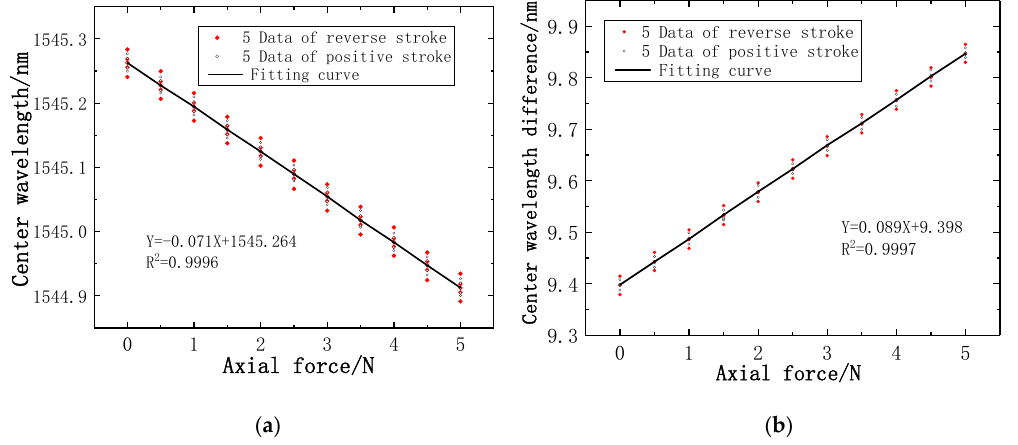
Figure 13. Wavelength and axial force relation curves of two FBGs: ( a ) Center wavelength fitting curve of FBG3; ( b ) Fitting curve of central wavelength difference between FBG3 and FBG2. In the experiment, the main sensing fibers are FBG1 and FBG3, FBG2 is a reference fiber. FBG2 is not affected by the pressure and torque force. The little change of temperature is the main factor affecting the Bragg wavelength of FBG2, so the trend of the values measured by FBG2 is not obvious. The Bragg wavelength of FBG2 fluctuates slightly up and down near the reference line, as presented in Figure 14.